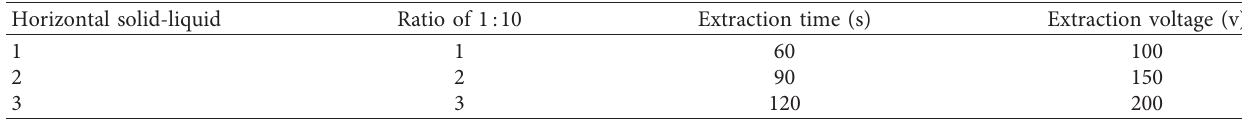
Table 1: Factor levels of the flash extraction method.